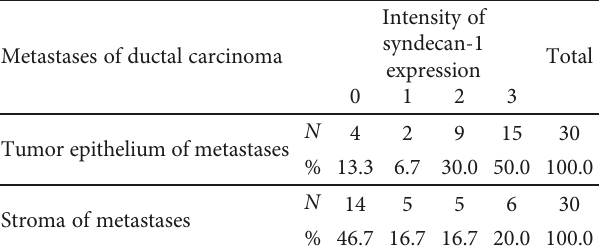
Table 3: The distribution of the intensity of the Sdc1 expression by levels in the tumor epithelium and the stroma of the metastases of the ductal breast cancer in the axillary